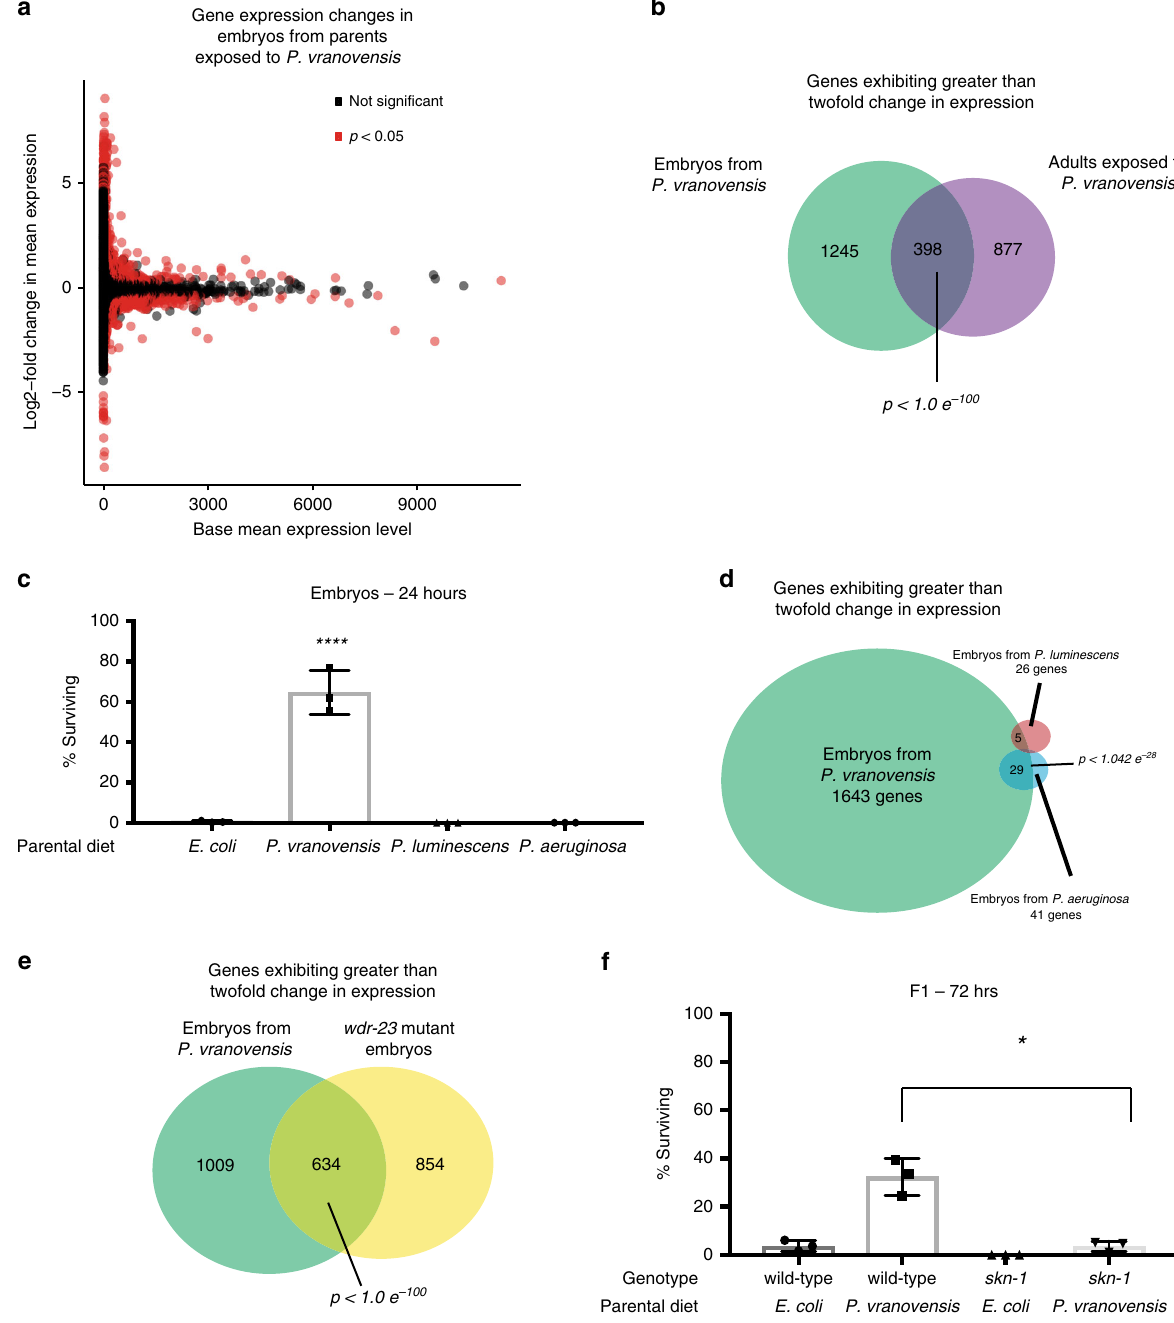
Fig. 3 Parental infection by P. vranovensis alters gene expression in offspring. a Gene expression changes in embryos from parents fed P. vranovensis BIGb446 when compared to embryos from parents fed E. coli HB101. Values represent averages from three replicates. b Venn diagram of genes exhibiting a greater than two-fold change in RNA expression in adults fed P. vranovensis BIGb446 and embryos from adults fed P. vranovensis BIGb446. p -value represents normal approximation to the hypergeometric probability (see section “ Statistics and reproducibility ” ). c Percent of F1 wild-type animals surviving on plates seeded with bacterial isolate BIGb446 after 24 h. P0 animals were fed their normal laboratory diet of E. coli HB101 or were exposed to the bacterial pathogens P. vranovensis BIGb446 , P. aeruginosa PA14, or P. luminescens Hb for 24 h. Data presented as mean values ± s.d. n = 3 experiments of 500 animals. d Venn diagram of genes exhibiting a greater than two-fold change in RNA expression in embryos from parents fed P. vranovensis BIGb446, P. aeruginosa PA14, and P. luminescens Hb. p -value represents normal approximation to the hypergeometric probability (see section “ Statistics and reproducibility ” ). e Venn diagram of number of genes exhibiting a greater than two-fold change in RNA expression in embryos from parents exposed to P. vranovensis BIGb446 and wdr-23(mac32) mutant embryos. p -value represents normal approximation to the hypergeometric probability (see section “ Statistics and reproducibility ” ). f Percent of wild-type and skn-1(zj15) mutants surviving on plates seeded with P. vranovensis BIGb446 after 72 h. Error bars, s.d. n = 3 experiments of >100 animals. Source data are provided as a Source Data fi le. * p = 0.0057, **** p < 0.0001. See section “ Statistics and reproducibility ” for statistical tests